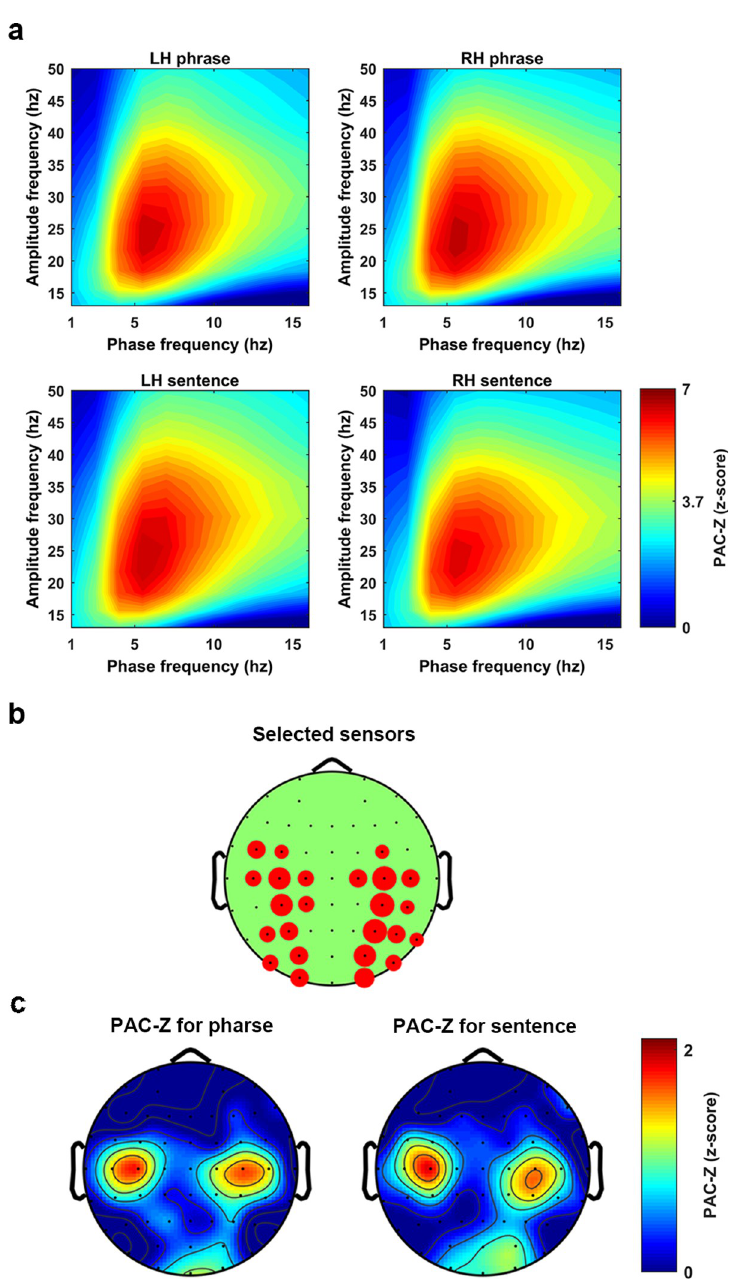
Fig 4. PAC as a general mechanism for speech perception. The figure shows a z-score transformed PAC, PAC-Z. (a) The PAC-Z for the phrases and the sentences at each hemisphere. Each figure was created by averaging 8 sensors which showed the biggest PAC-Z over the ROI. A z-score transformation with Bonferroni correction was conducted to test the significance, which lead to the threshold to be 3.73 corresponding to p -value equals 0.05. (b) The figure shows how sensors were selected at each hemisphere. The bigger the red circle indicates the more times this sensor was selected across participants. (c) The topographical distribution of the PAC-Z, which indicates the PAC was largely localized at the bilateral central areas. PAC, phase amplitude coupling; ROI, region of